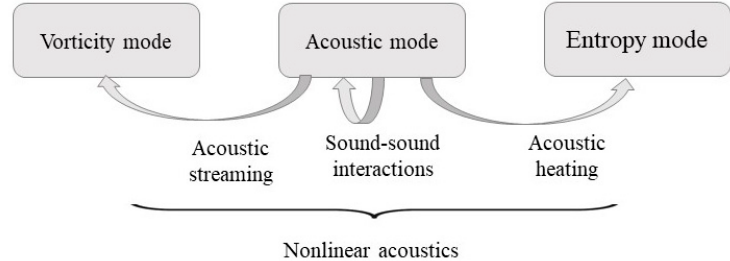
Figure 1. Study of nonlinear acoustics [Adopted based on a figure in Sapozhnikov (2015)].